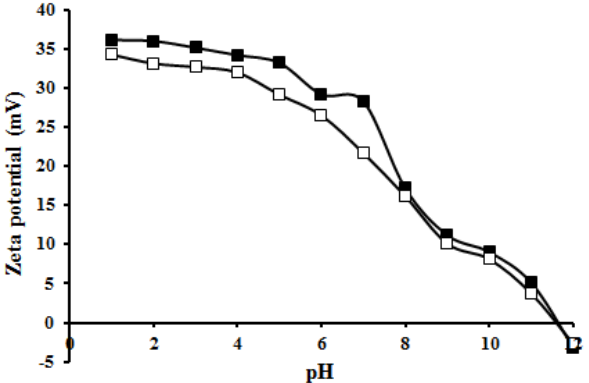
Fig. 1 . Zeta potential curves of TMU-16 (  ) and TMU-16-NH